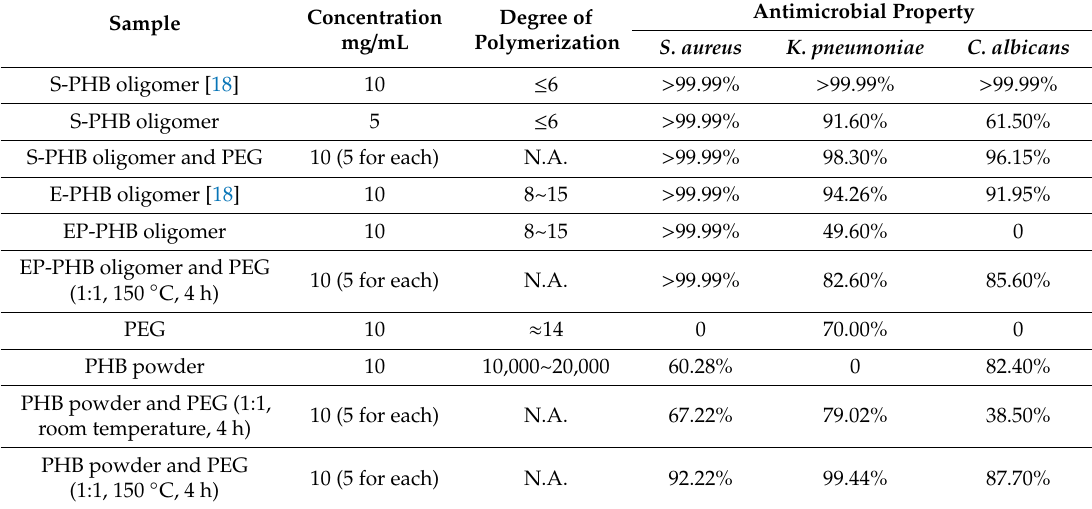
Figure 2. HPLC-MS spectrum of E-PHB and EP-PHB oligomer. Table 2. Synergy between PHB oligomer and